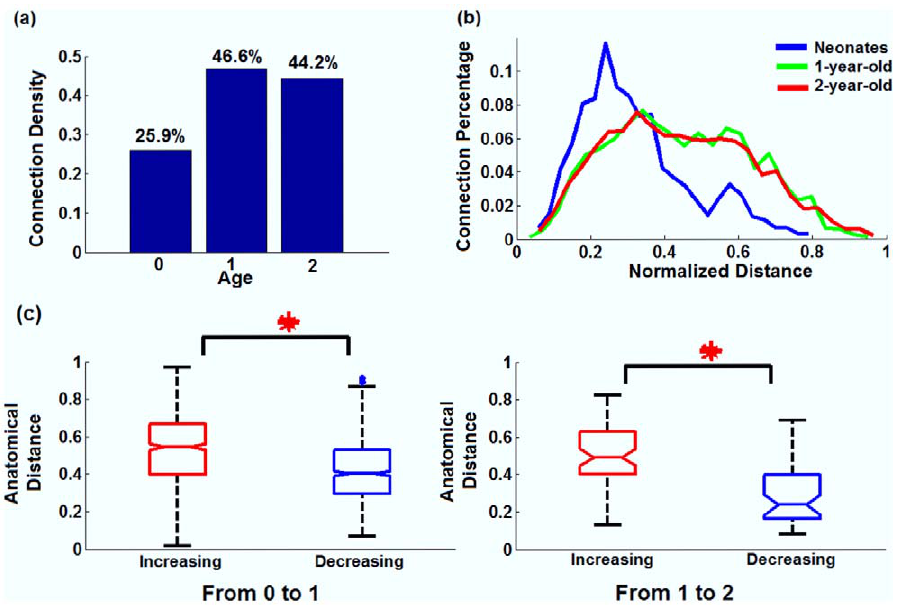
Figure 1. Age-dependent growth pattern of functional connecti (a) the connection density plot of all three age groups (based on statistical testing of connections (P , 0.05, FDR corrected)); (b) the histogram plots of the normalized anatomical distance associated with the significant connections for each age group; (c) statistical comparisons of the anatomical distances associated with those connections that exhibit significantly changed strength with age. Red: increasing connections with age; blue: decreasing connections with age.